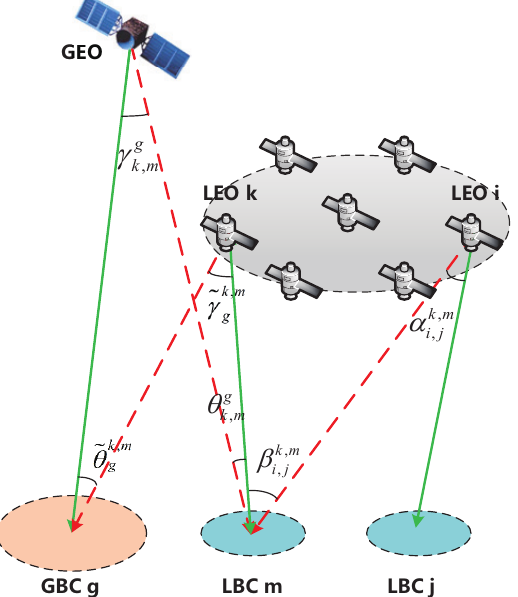
Figure 2. The GEO-LEO interference model and the definitions of different off-axis